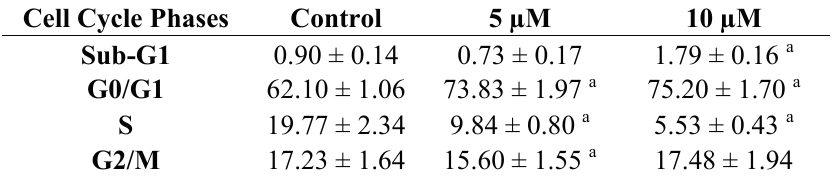
Table 1. Cell cycle analysis after 48 h of treatment with